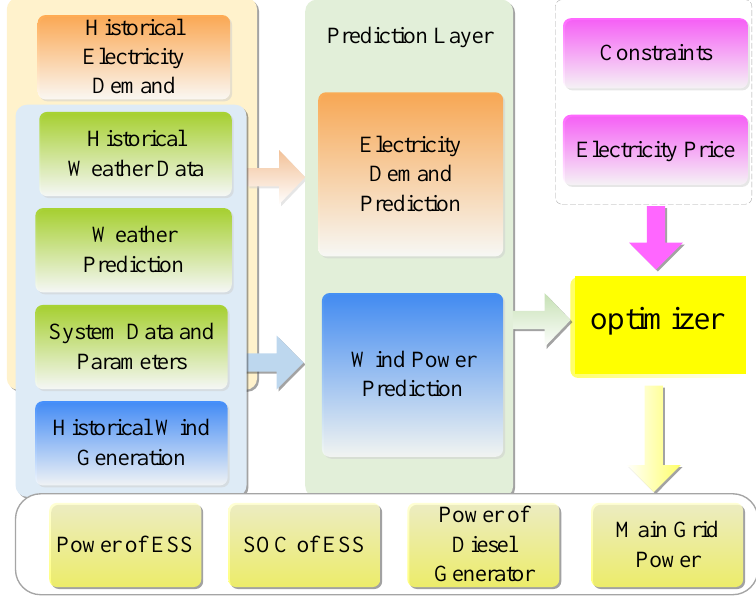
Figure 2. Proposed microgrid energy management system (MG EMS) configuration. SOC: state of charge and ESS: energy storage system.